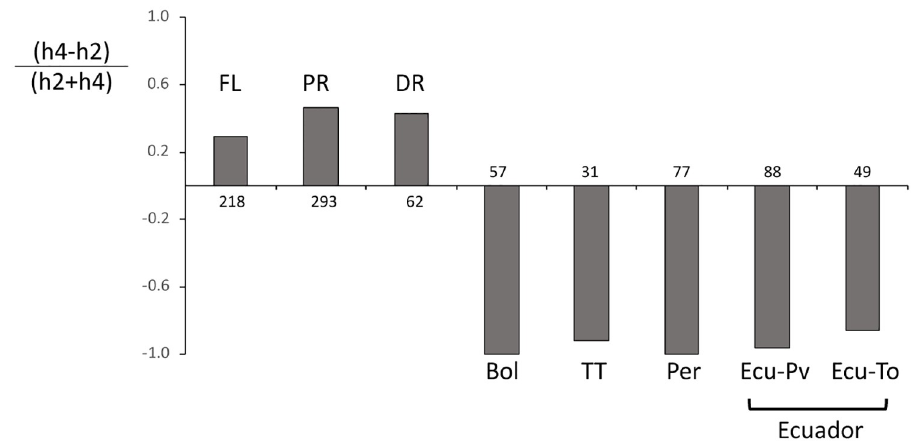
Fig 4. Frequency distributions of the COIB h-haplotypes, h1-4, for Ecuador and select locations in the Western Hemisphere. Numbers indicate the number of COI -CS specimens. Data for Florida (FL), Puerto Rico (PR), Dominican Republic (DR), Bolivia (Bol), Trinidad-Tobago (TT) and Peru (Per) were from Nagoshi et al. (2016) [33]. Ecuador specimens are from Portoviejo (Ecu-Pv) and Tosagua (Ecu-To).